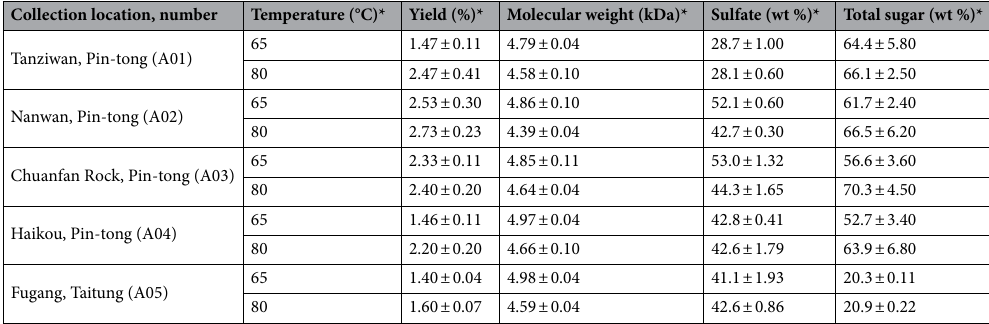
Table 1. Yield, sulfate, total sugar, and molecular weight results of fucoidan. *Each value represents the mean ± SD of three determinants of the obtained fractions.